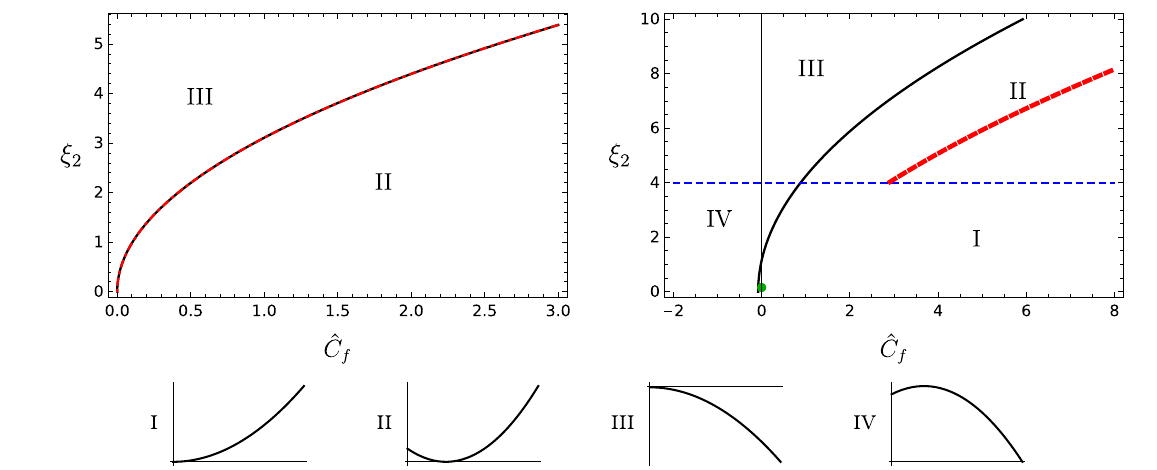
Fig. 6 Stability properties of the effective potential f ( x ) , see Eq. (70), for P ∈ ( 0 , 1 / 2 ) (upper left) and P = 1 / 2 (upper right). The two black lines separate the left-hand side regions where the potential is unbounded from below from the right-hand side regions where it is bounded, and in the h 2 → 0 limit. Their equations are obtained impos- ing the condition ˆ C f , ∞ = 0 in Eq. (74). Sketches of the potential shapes in the different regions are given in the lower panels. Upper right: the blue dashed line ξ 2 = 4 identifies the locus of points where f (cid:10) ( 0 ) = 0.